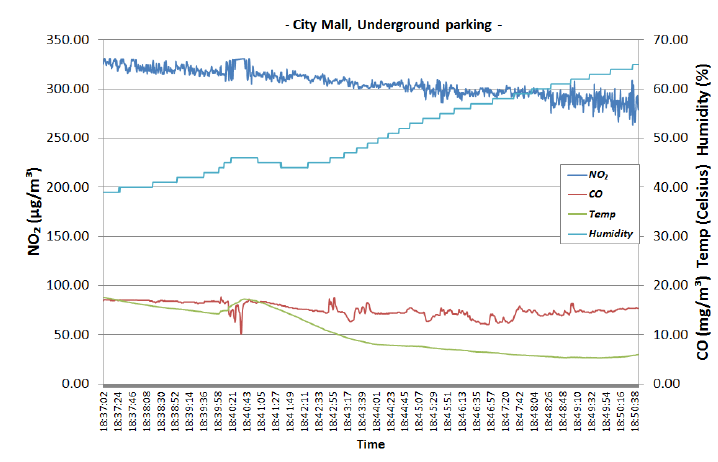
Figure 15. City mall underground parking—first time interval.